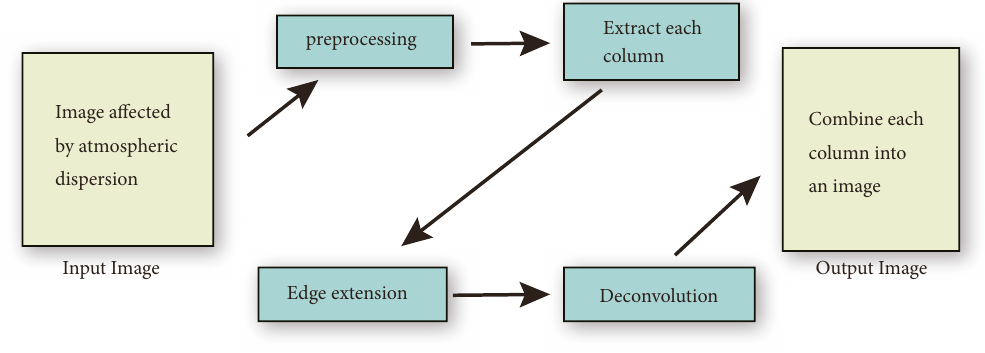
Figure 2: Block diagram of the proposed